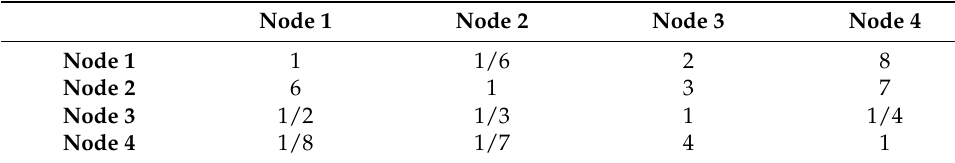
Table A1. Pairwise comparison matrix for distance criterion.